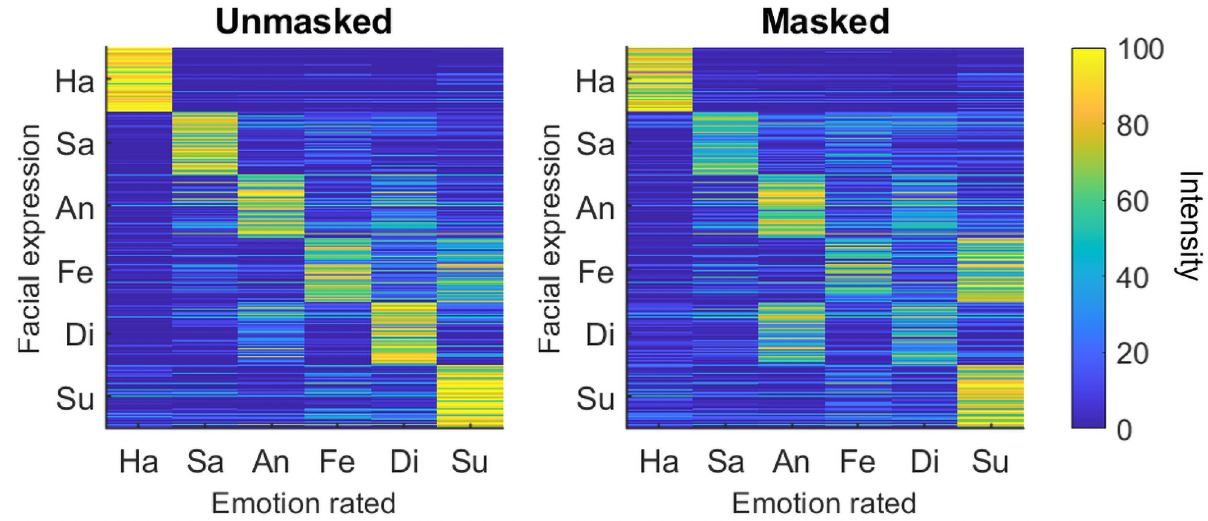
Fig 3. Confusion matrices showing participants’ emotion intensity ratings for each emotional expression (excluding neutral). Individual participant ratings for each facial expression are presented in individual rows, and the rated emotion is indicated by the columns.